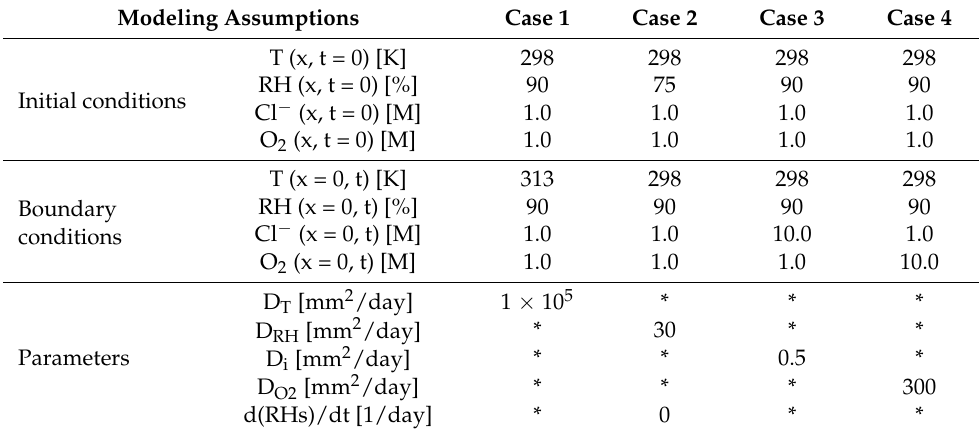
Table 2. Initial and boundary conditions and modeling parameters for verification